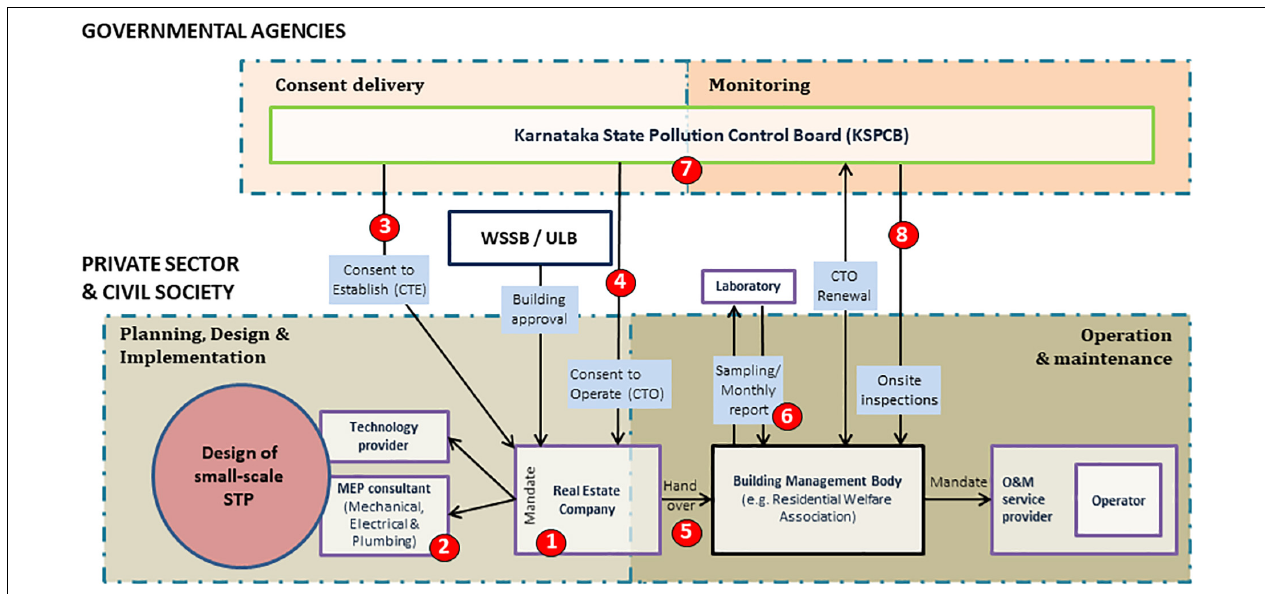
FIGURE 3 | Stakeholders, procedures and governance arrangements through the life-cycle of a small-scale wastewater treatment system in the state of Karnataka. The red numbers refer to the main weaknesses explained in the text.